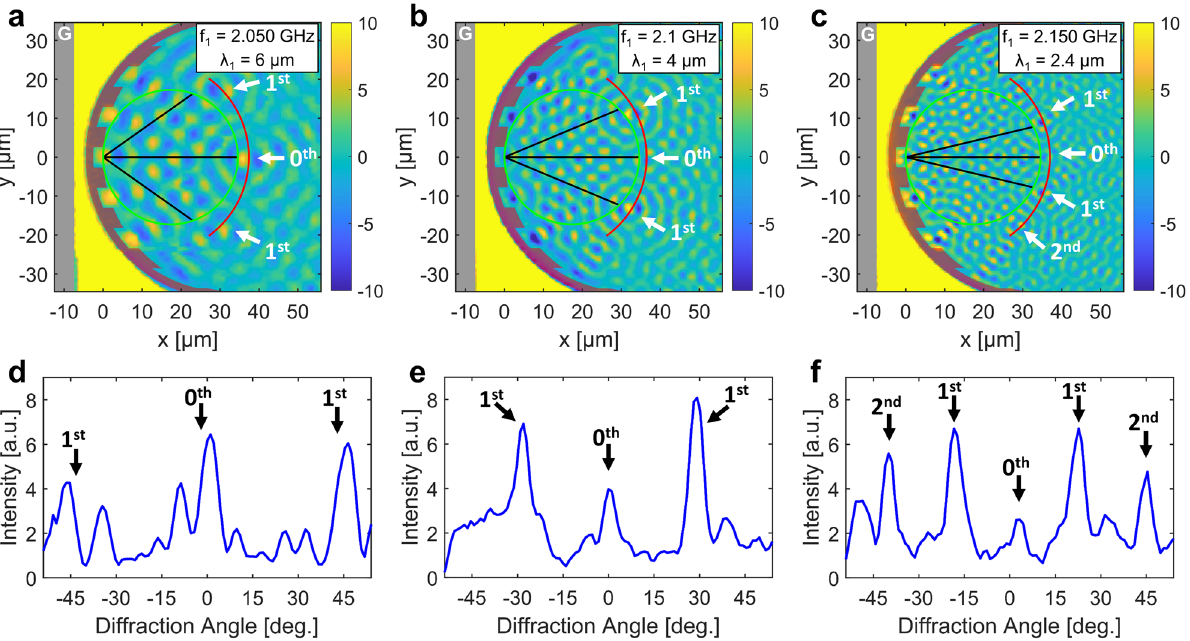
Figure 2. Spin-wave interference patterns recorded by trMOKE at three different excitation frequencies at constant bias field. In ( a – c ) the FIB irradiated region (grating) is indicated by a semi-transparent red overlay (radius R=30 µm, pitch d=12 µm), the gray stripe represents the ground line of the CPW. The green circles are the theoretical Rowland circles with a radius R/2, while the radius of red arcs are fitted to the data. Black lines indicate expected diffraction angles, and white arrows point to focal points in the measured data. The microwave power is kept constant at 5 dBm. ( d – f ) Spin-wave intensities extracted along the red arcs in ( a – c